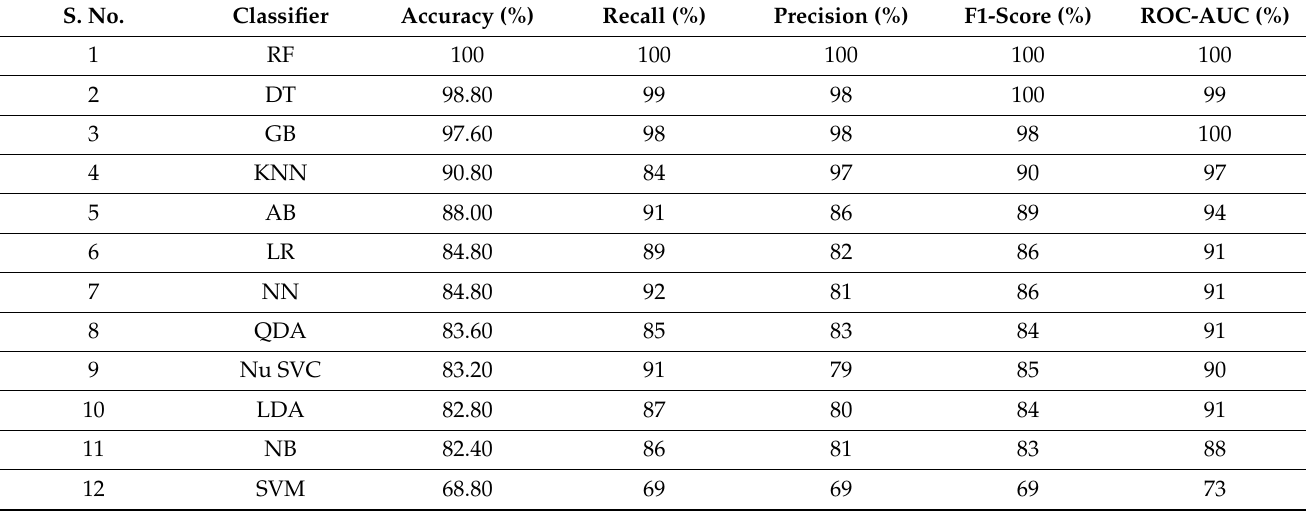
Table 2. Results of different machine learning models.